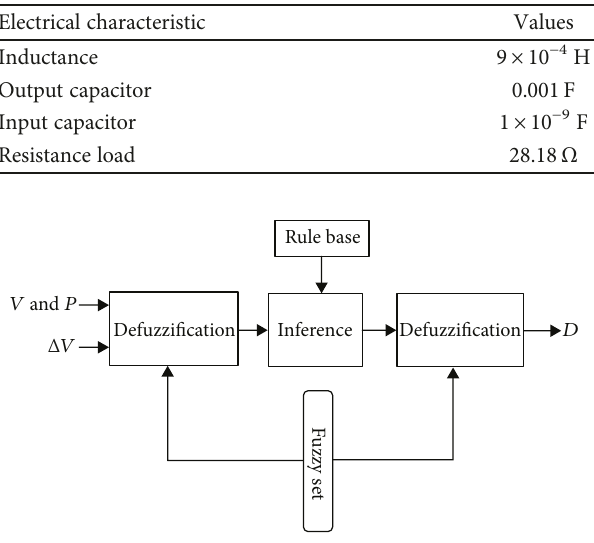
Figure 5: General diagram of a fuzzy controller.